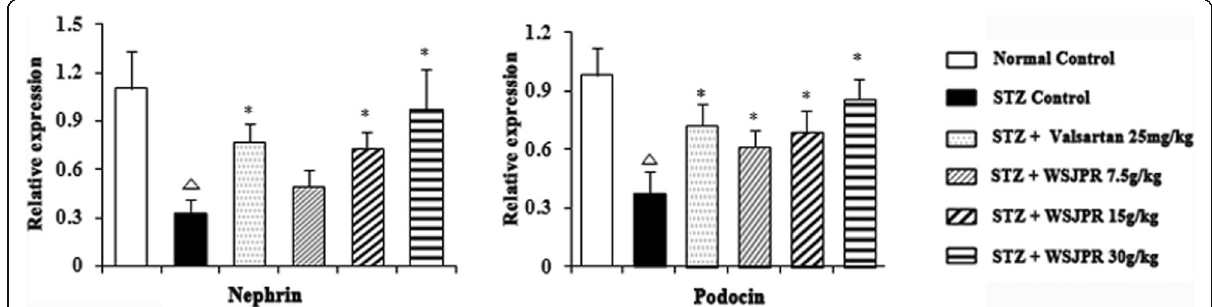
Fig. 7 Effect of WSJPR on the transcriptional levels of nephrin and podocin gene in rats ( n = 8). △ P < 0.05 vs. normal control and * P < 0.05 vs. STZ control; mean ±